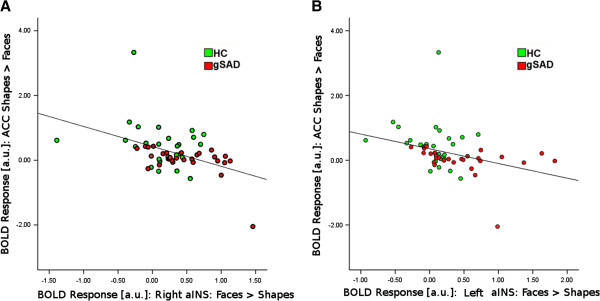
Correlation between extent of activation from the anterior cingulate cortex (ACC) ROI and extent of activation in A) right anterior insula and B) left anterior insula ROIs across all subjects. Generalized Social Anxiety Disorder subjects are coded in red; Healthy Controls are coded in green.